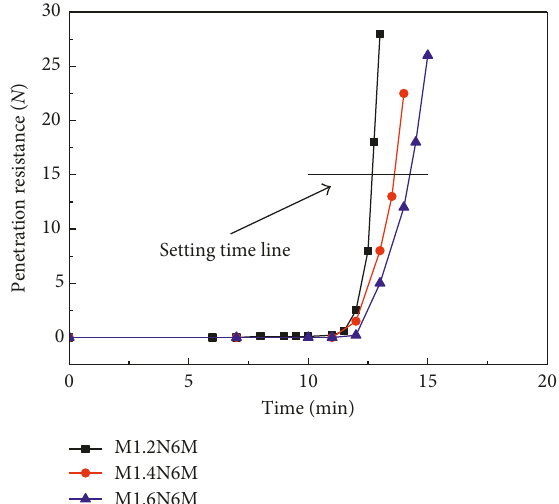
Figure 5: The effect of the silicate moduli on the setting time of AAS mortars.